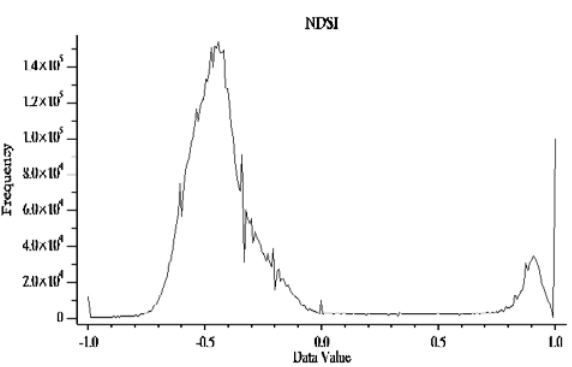
Figure 6. Histogram of the NDSI grayscale image